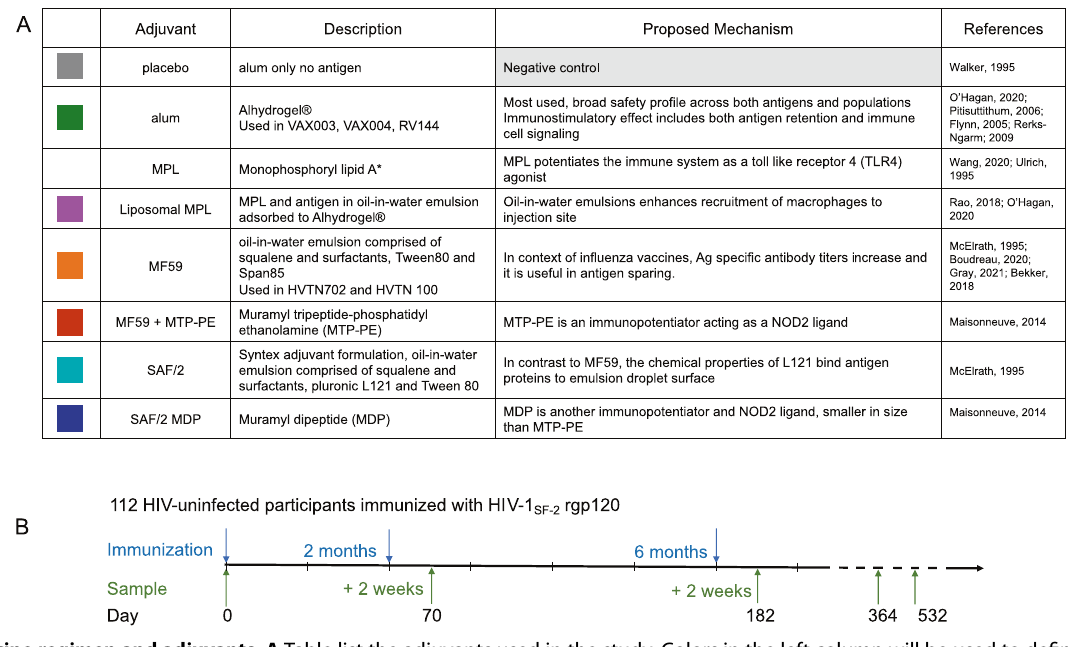
Fig. 1 Vaccine regimen and adjuvants. A Table list the adjuvants used in the study. Colors in the left column will be used to de fi ne arms. *The MPL arm was excluded from analysis due to adverse effects. B Timeline depicts immunization and sample collection schedule.